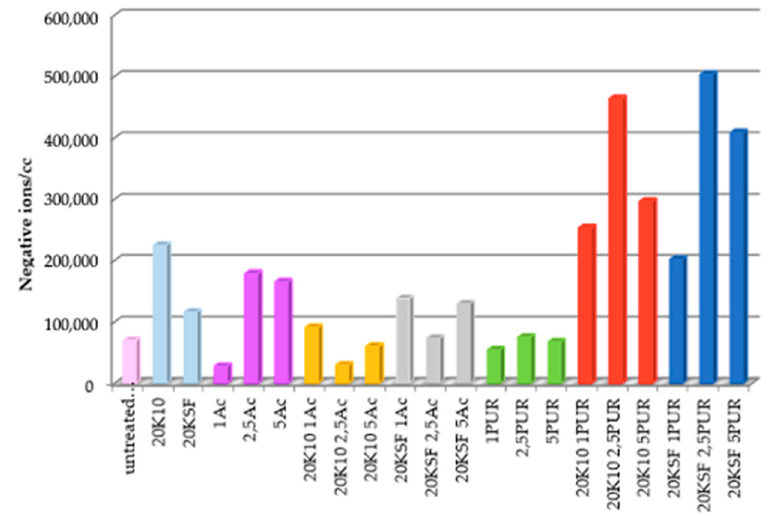
Figure 4. Average of total negative ions/cc in the air for 15 min.